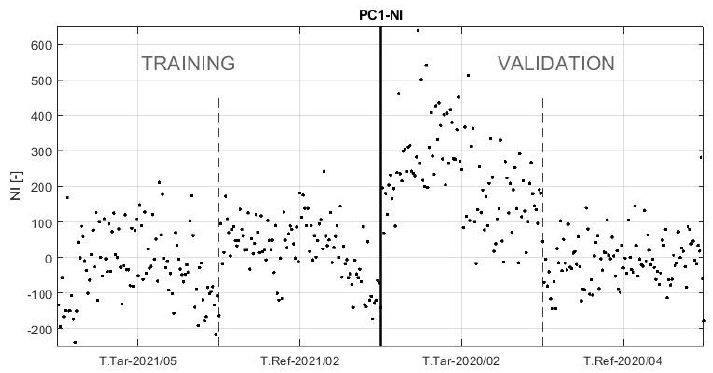
Figure 10. NI computed on the four considered datasets: the statistical difference between the Ref. validation dataset and the Tar. one is evidenced by the novelty index.